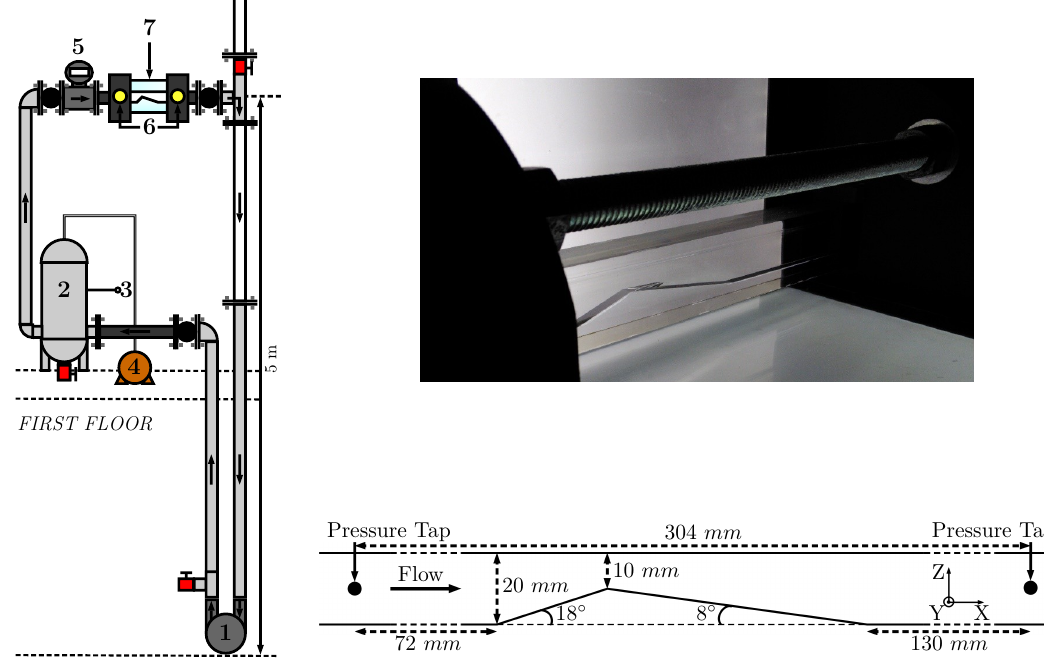
Figure 1. Sketch of the Venturi geometry. The width of the test section is w = 10 mm and its height at the inlet section is h in = 20 mm. In the following of the article the axes origin is positioned at the Venturi throat edge in the middle of test section along the width. Reprinted with permission from K. Croci, Ph.D. dissertation